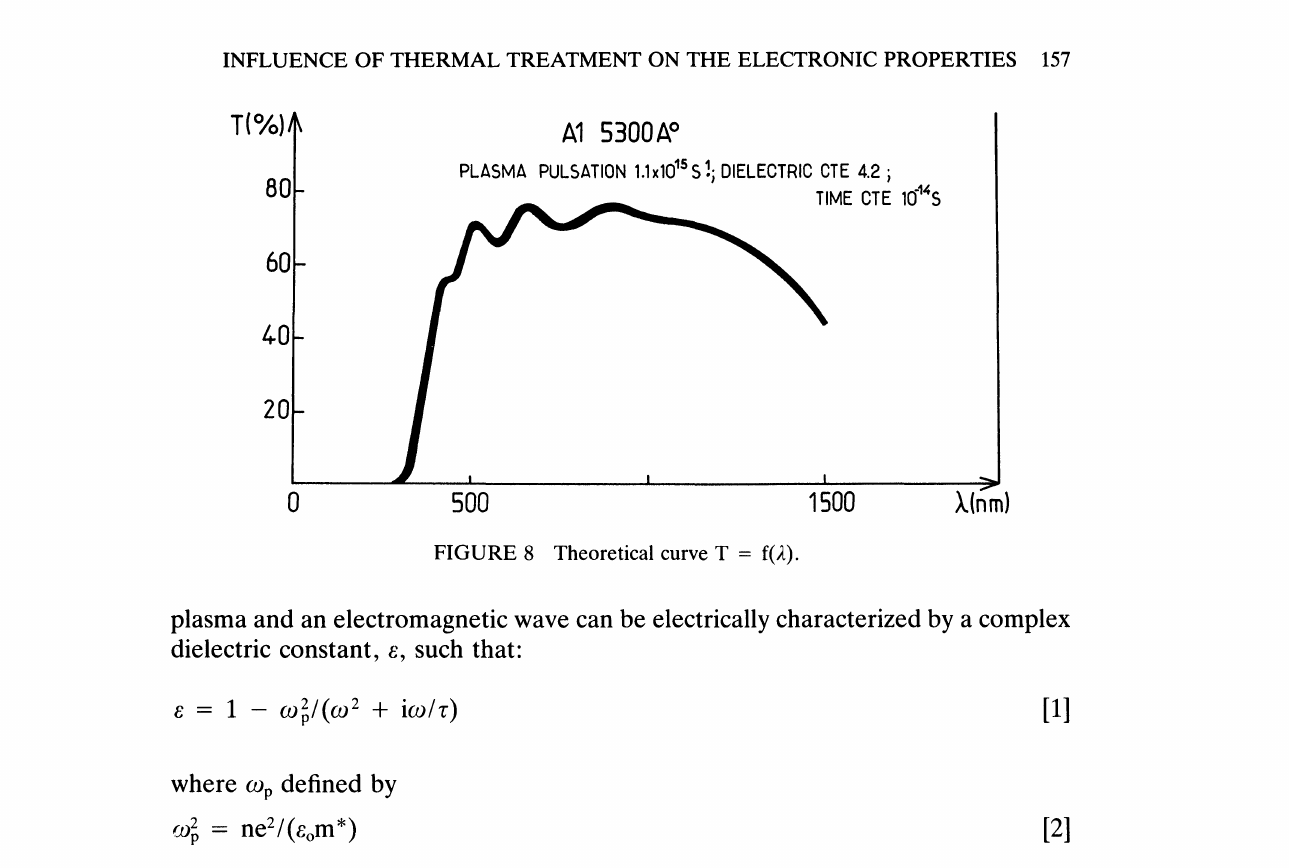
FIGURE 8 Theoretical curve T